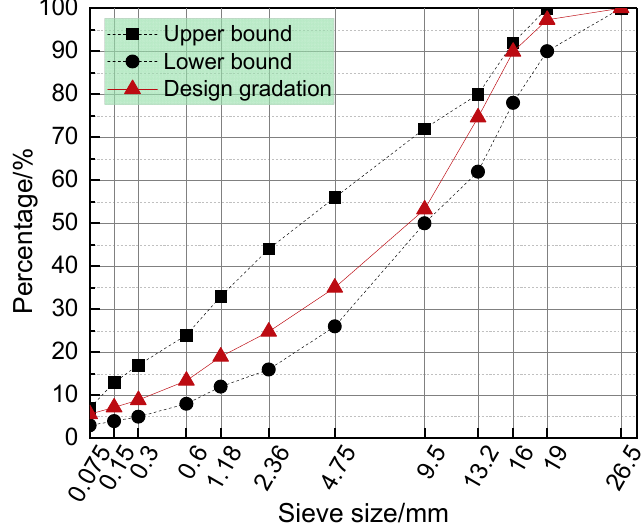
Figure 2. Grading curve of RHMA.